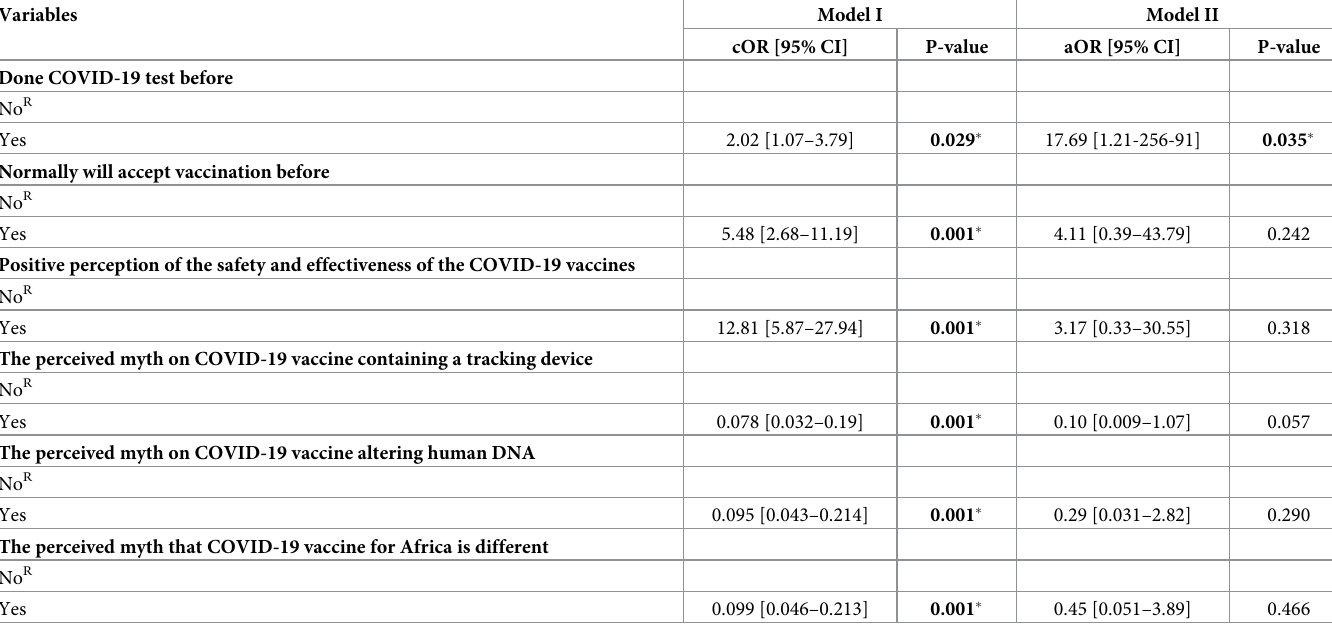
Table 9. Factors associated with the willingness to accept COVID-19 vaccines (n =